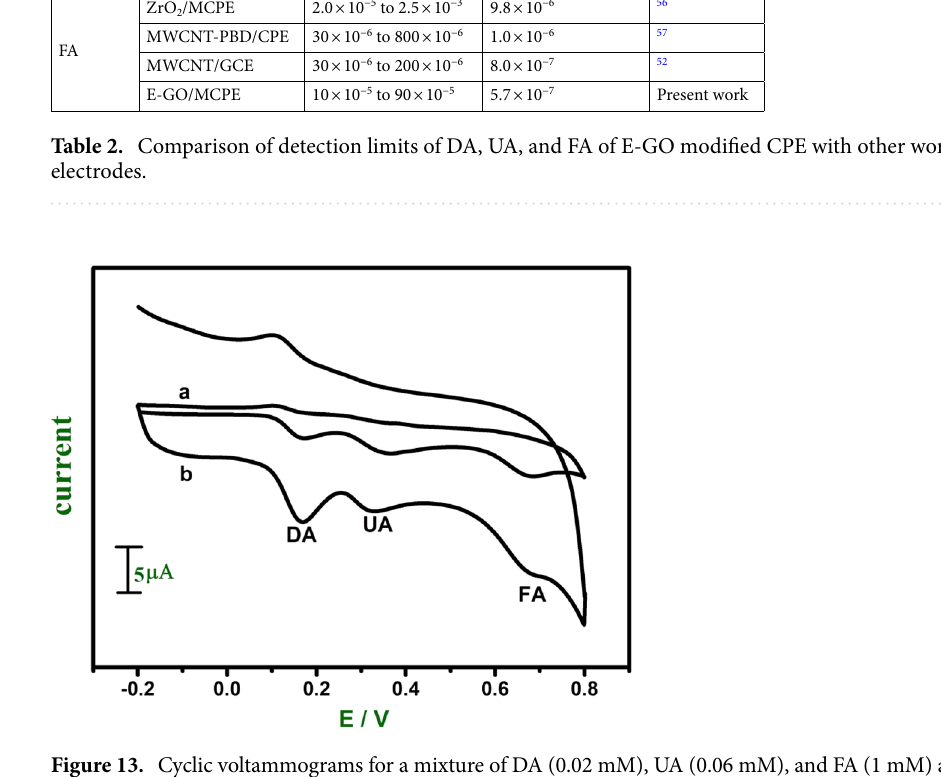
Figure 13. Cyclic voltammograms for a mixture of DA (0.02 mM), UA (0.06 mM), and FA (1 mM) at bare CPE (curve a ) and E-GO modified CPE (curve b ) in 0.2 M phosphate buffer solution of pH